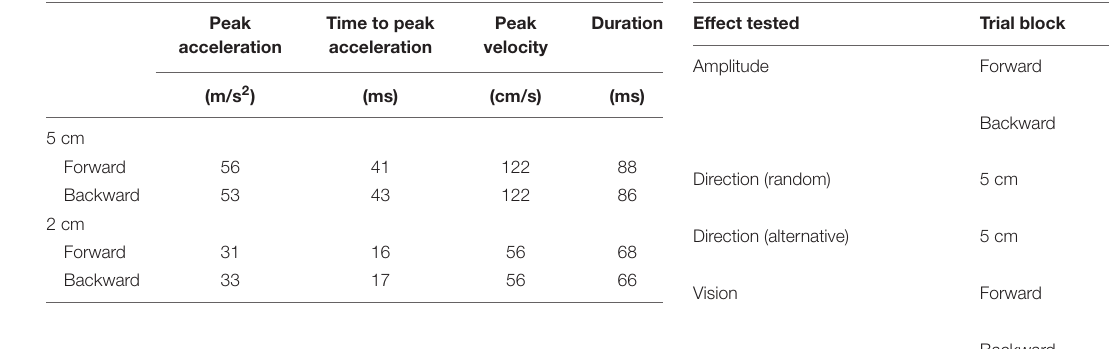
TABLE 1 | Parameters of movable platform. TABLE 2 | Trial blocks in Experiment